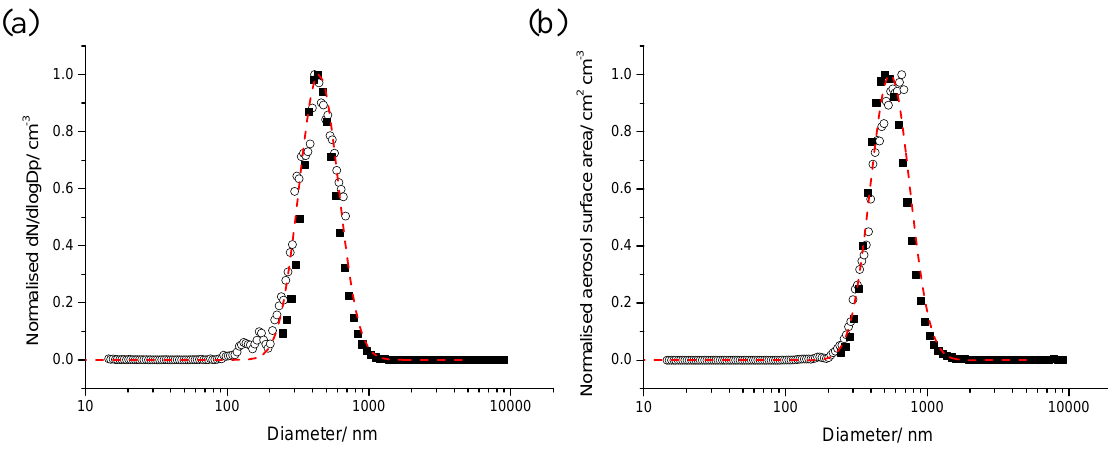
Figure 2. Normalised (a) number weighted and (b) surface weighted ATD aerosol size distributions recorded with the SMPS (open symbols) and the APS (closed symbols) positioned at the downstream end of the aerosol flow tube. The red line represents a log normal fitting to all the measured points from both instruments for the number-weighted